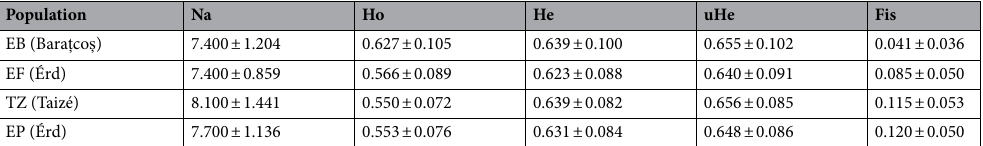
Table 1. Allelic richness, genetic diversity, and levels of inbreeding in the studied Polyommatus icarus populations as reported by GenAlEx (mean ± s.e.). Na number of different alleles, Ho observed heterozygosity, He expected heterozygosity, uHe genetic diversity, Fis fixation index.